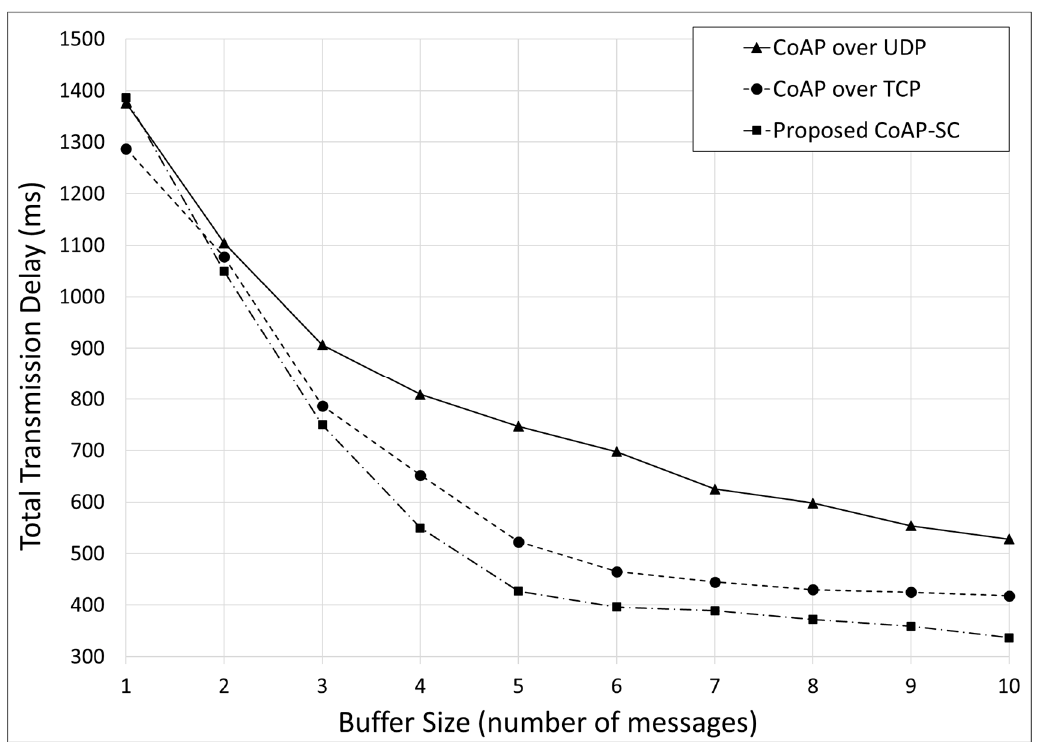
Figure 24. Total transmission delays for different buffer sizes.